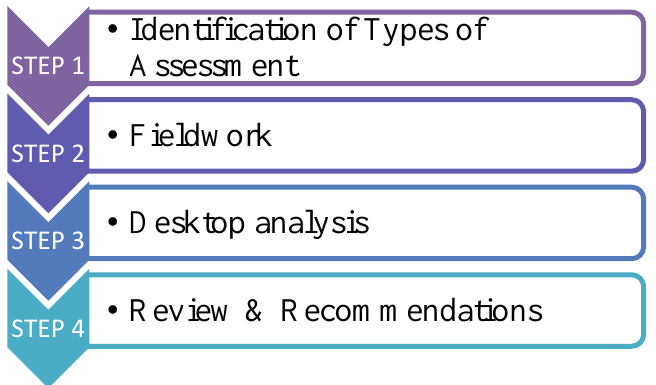
Figure 2: Four Steps in EWS Feasibility Study